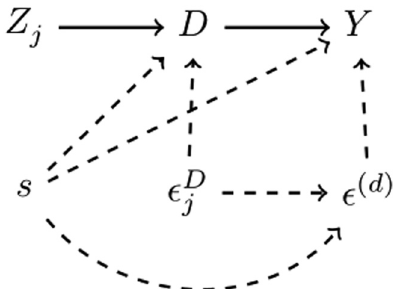
Figure 1: DAG under Assumptions 2.1 and